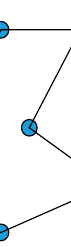
Figure 4. Schematic of TSP.